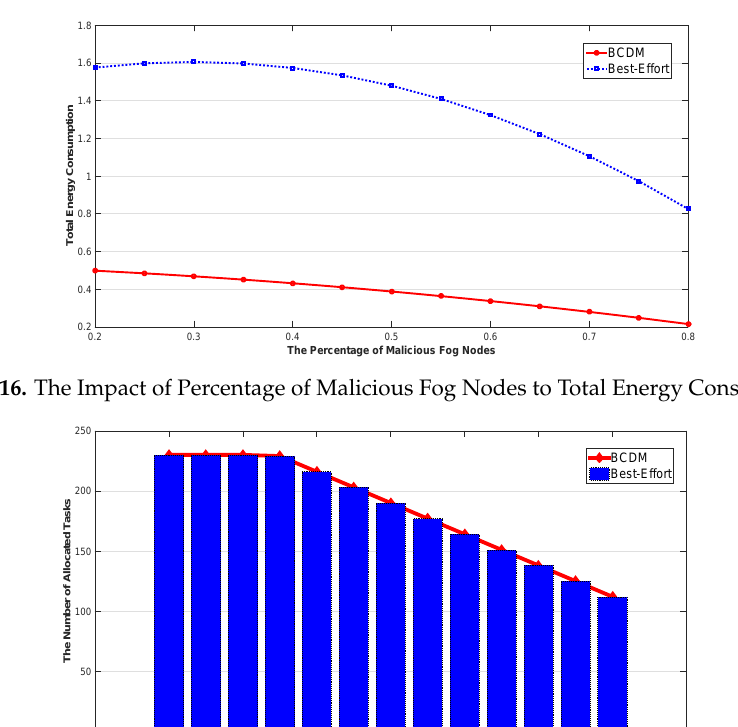
0.2 The Percentage of Malicious Fog Nodes Figure 15. The Impact of Percentage of Malicious Fog Nodes to Average Energy Consumption.